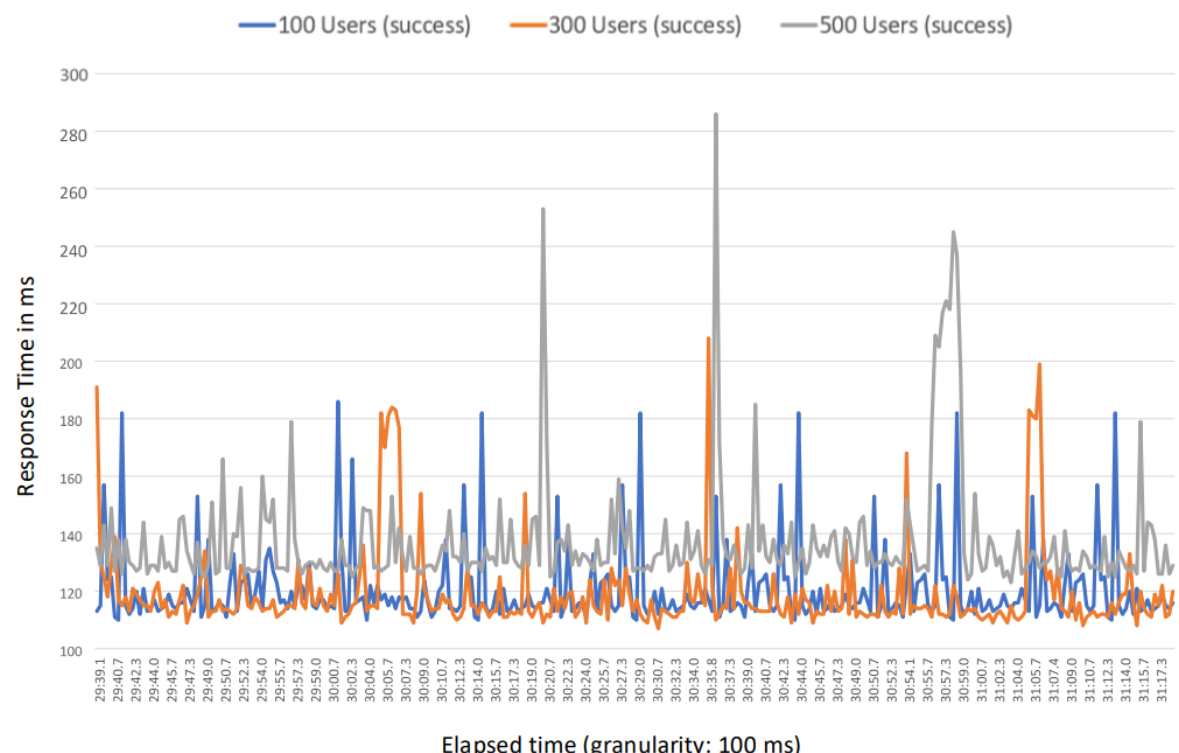
Figure 11. Response time for the various group of